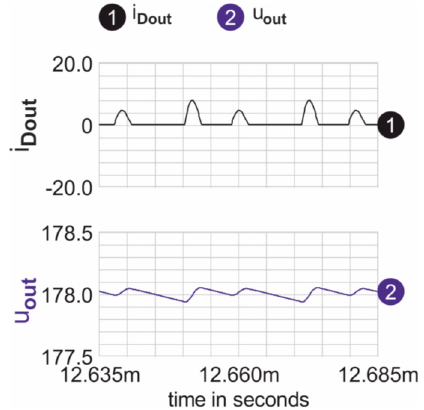
Figure 3. Steady-state output current and voltage waveforms of the LCSCVMb converter under switching strategy C1 (4 A/div and 100 mV/div). The results were obtained with the use of ICAP/4 simulation software.